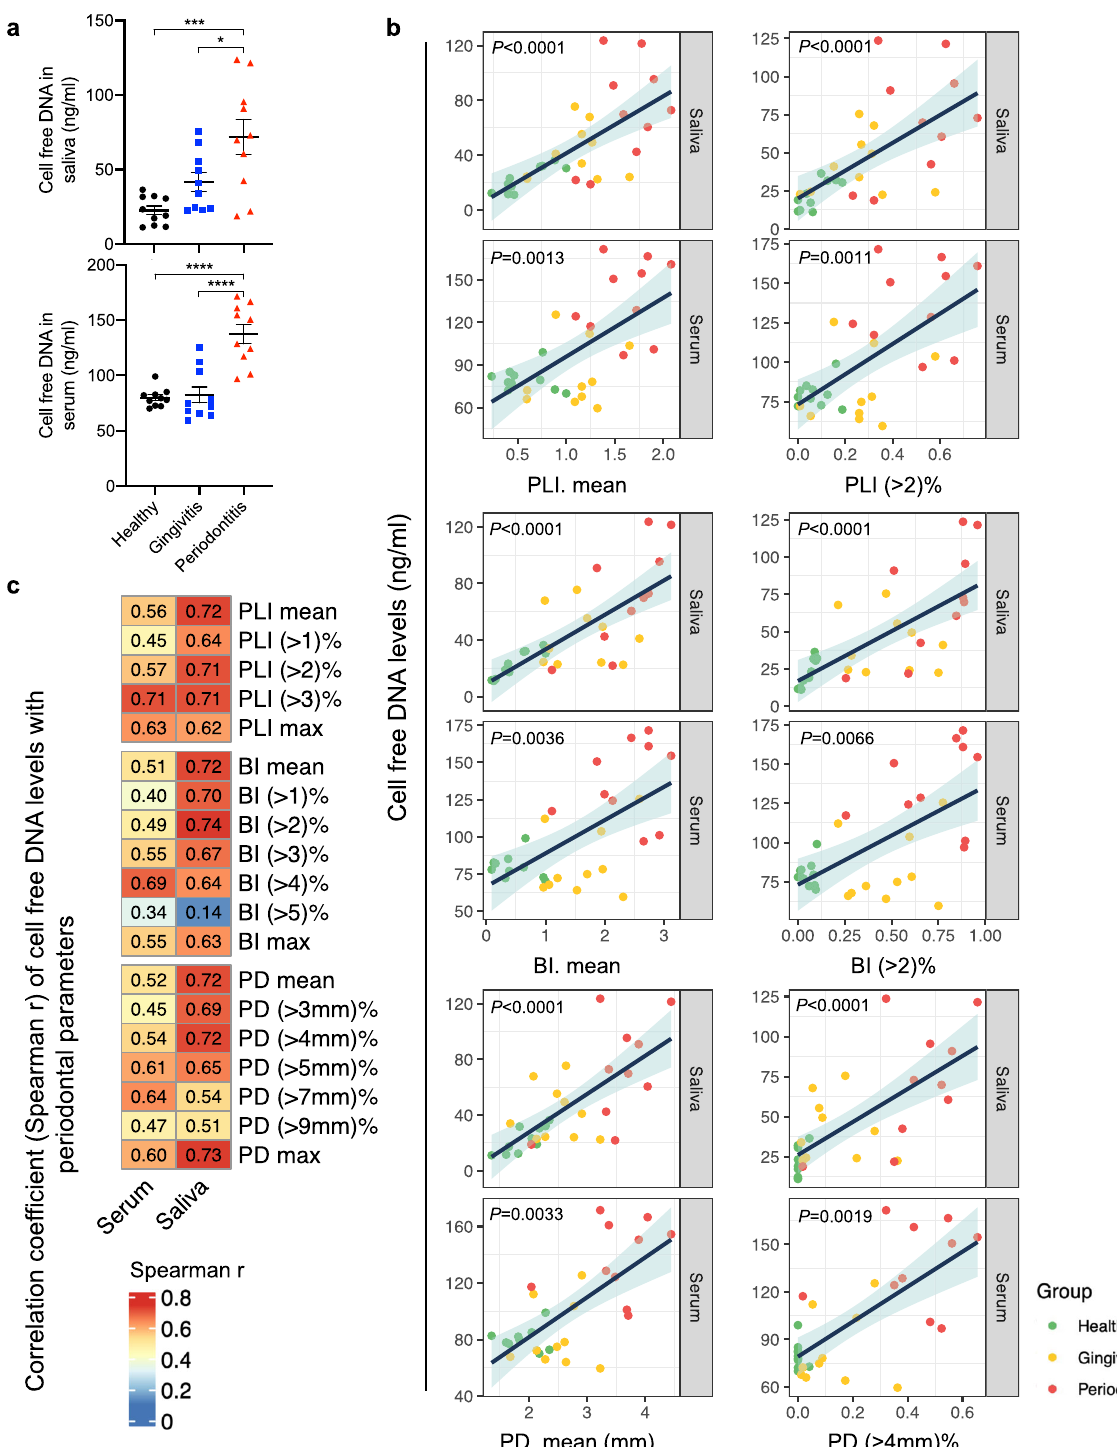
Fig. 1 | cfDNA concentration in saliva and serum is positively correlated with theseverityofperiodontalin fl ammation,andcfDNAinsalivashowedstronger correlation. a cfDNA levels in saliva and serum of healthy volunteers ( n =10), gingivitis patients ( n =10) and periodontitis patients ( n =10). Data are means± SEM; differences were assessed by one-way analysis of variance and Tukey ’ s mul- tiple comparisons test. * P <0.05, ** P <0.01, *** P <0.001, **** P <0.0001 (Saliva, P =0.0004 between Healthy and Periodontitis, P =0.0302 between Gingivitis and Periodontitis; Serum, P <0.0001 between Healthy and Periodontitis, P <0.0001 between Gingivitis and Periodontitis). b Scatter plot of cfDNA levels and